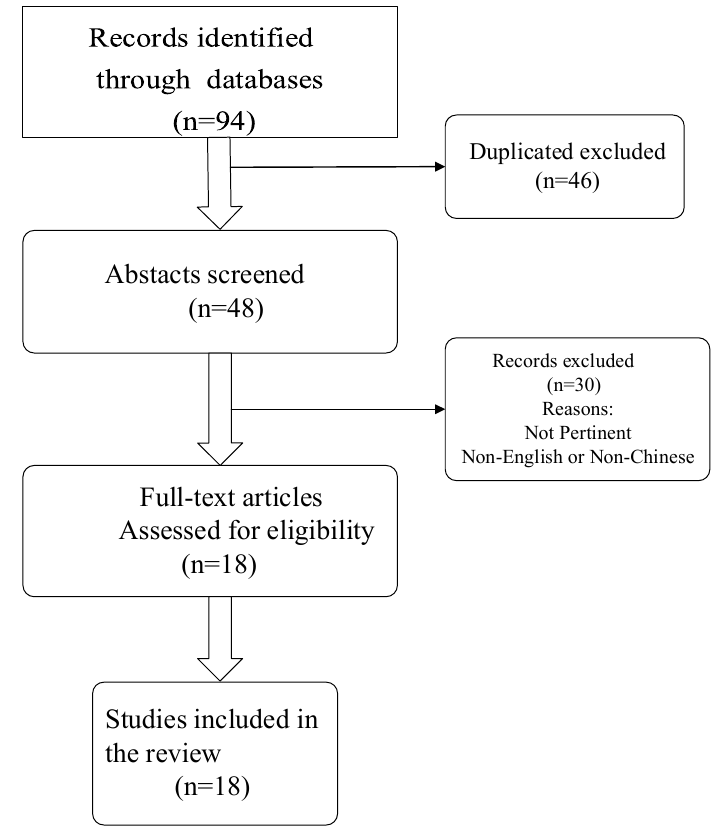
Figure 1. The flow chart of article selection process for this